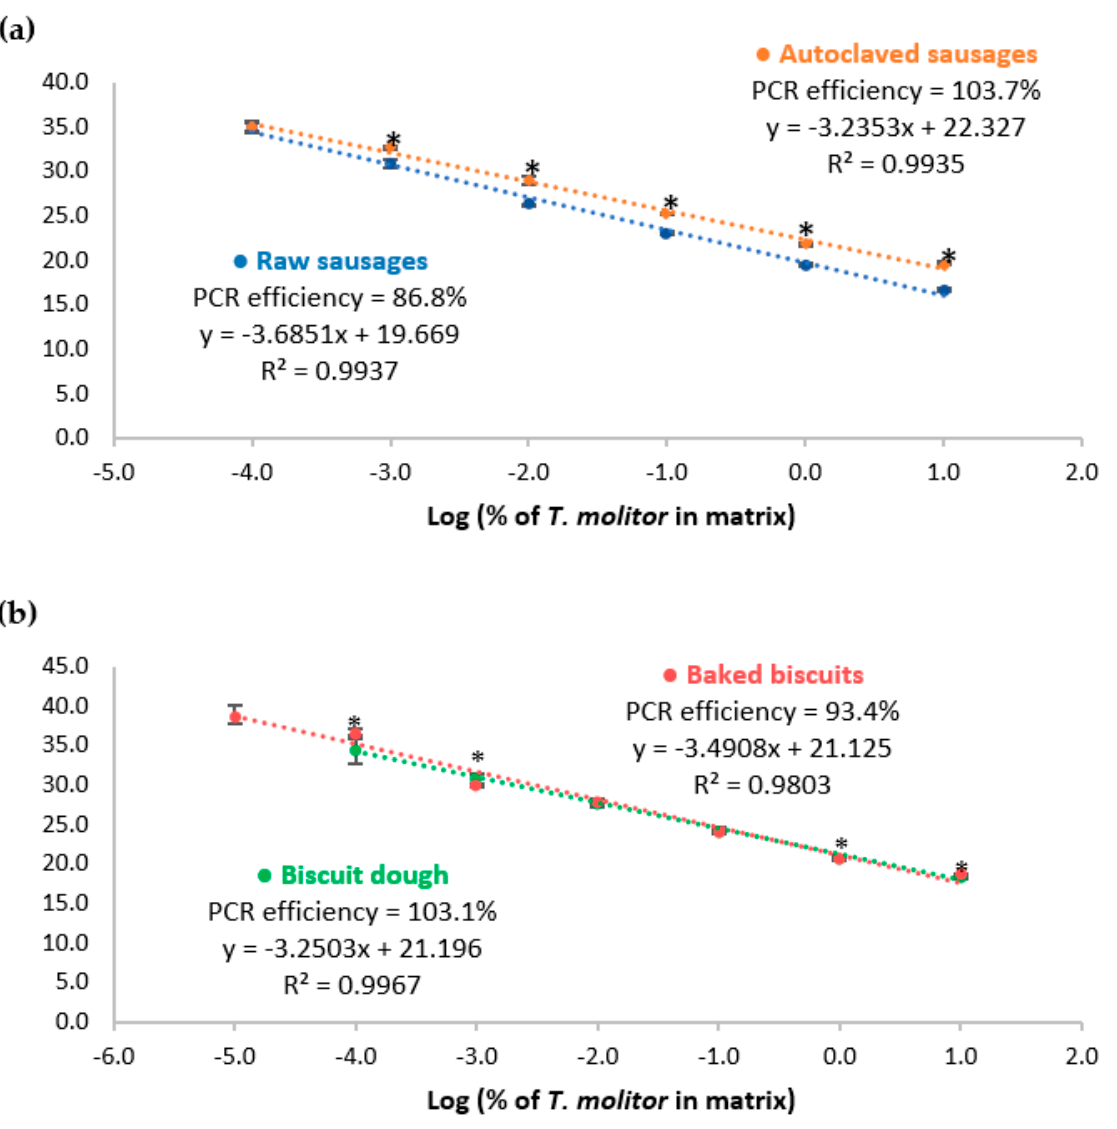
Figure 2. Calibration curves obtained by real-time PCR with TaqMan probe targeting cytochrome b gene using sausages ( a ) and biscuits ( b ) model mixtures before and after thermal treatment, containing 100,000 mg/kg; 10,000 mg/kg; 1000 mg/kg; 100 mg/kg; 10 mg/kg; 1 mg/kg; and 0.1 mg/kg ( w / w ) of mealworm ( n = 8 replicates). For the same spiking level, * means statistically significant differences between raw and processed mixtures ( p < 0.05), following t -test analysis. Table 2. Calibration curve parameters obtained by quantitative real-time PCR targeting cytochrome b gene, using model mixtures of sausages and biscuits containing T. molitor , before and after thermal treatment.